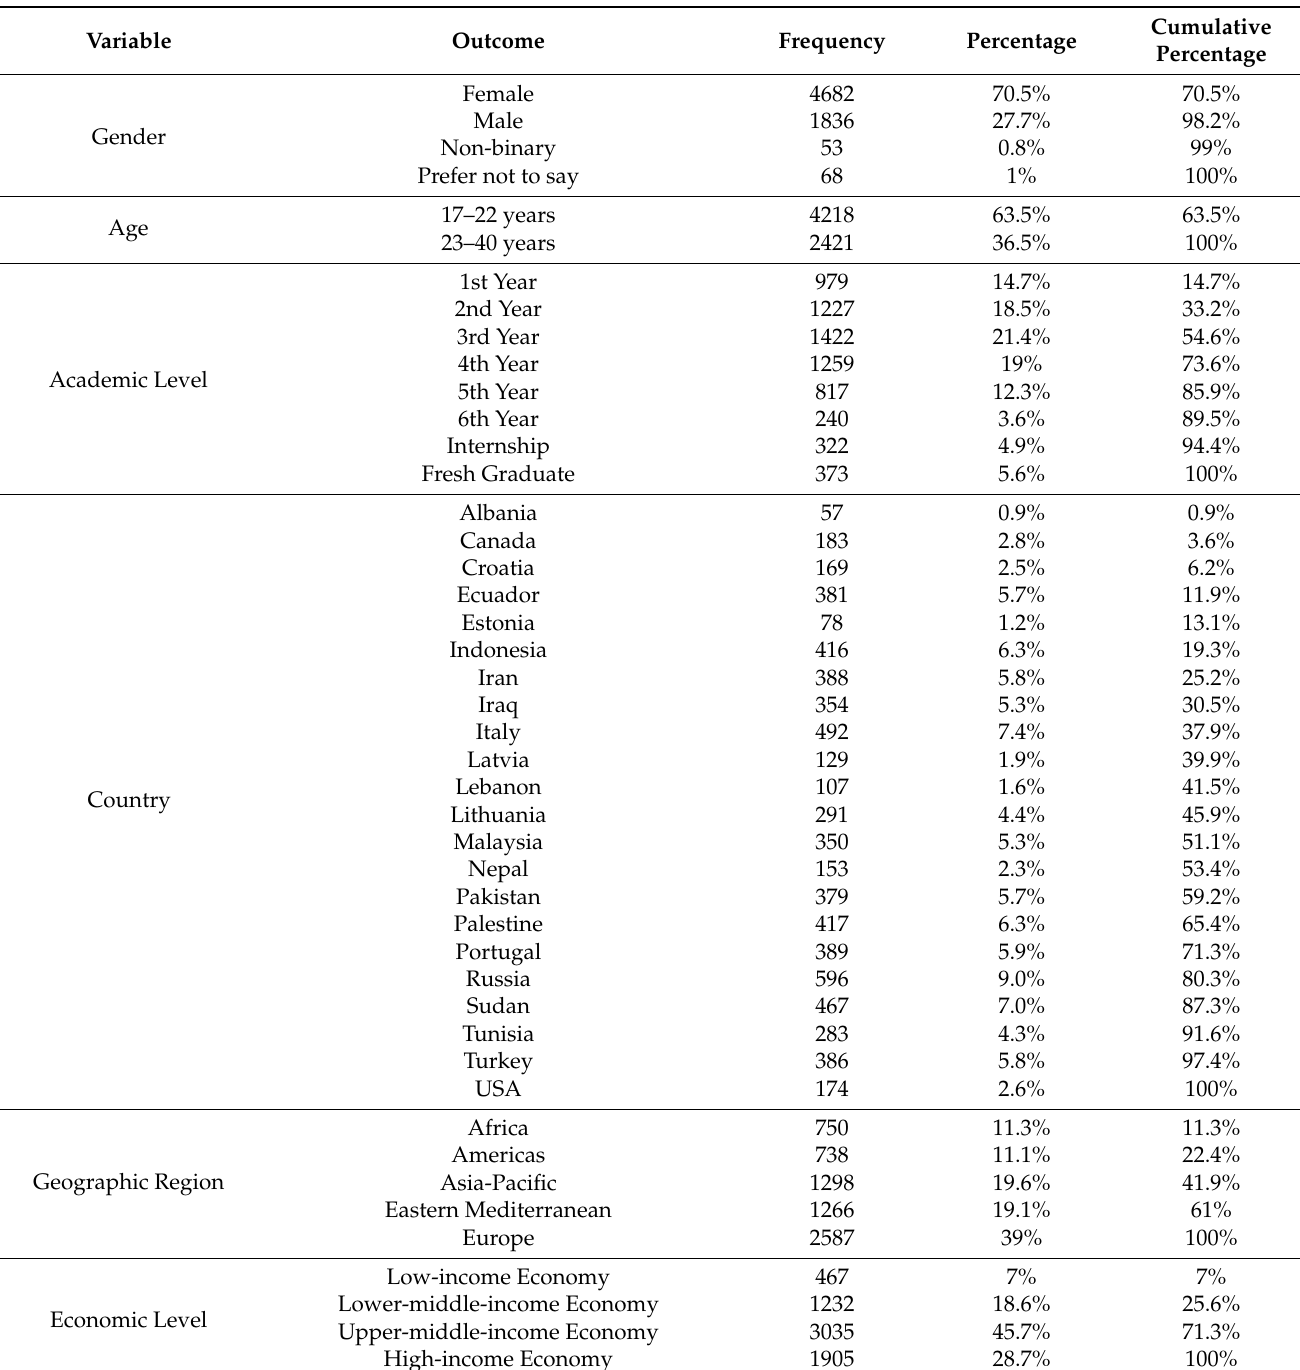
Table 2. Demographic characteristics of the participating dental students worldwide, February